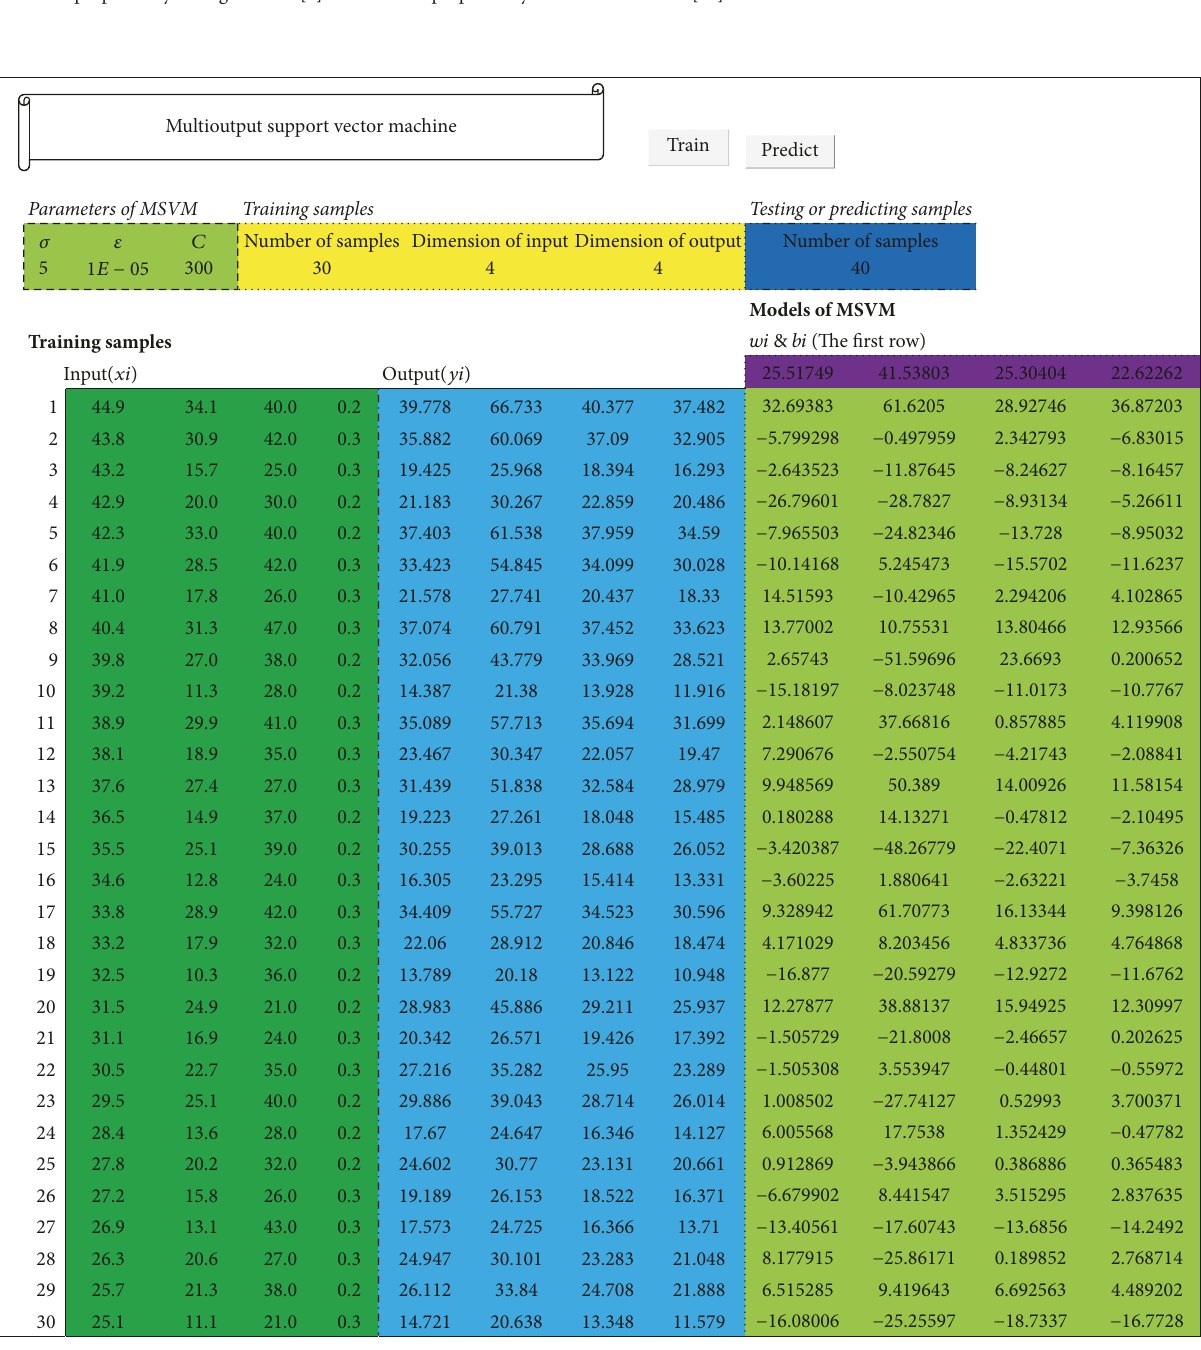
Figure 2: Parameters and model of MSVM in the Excel VBA